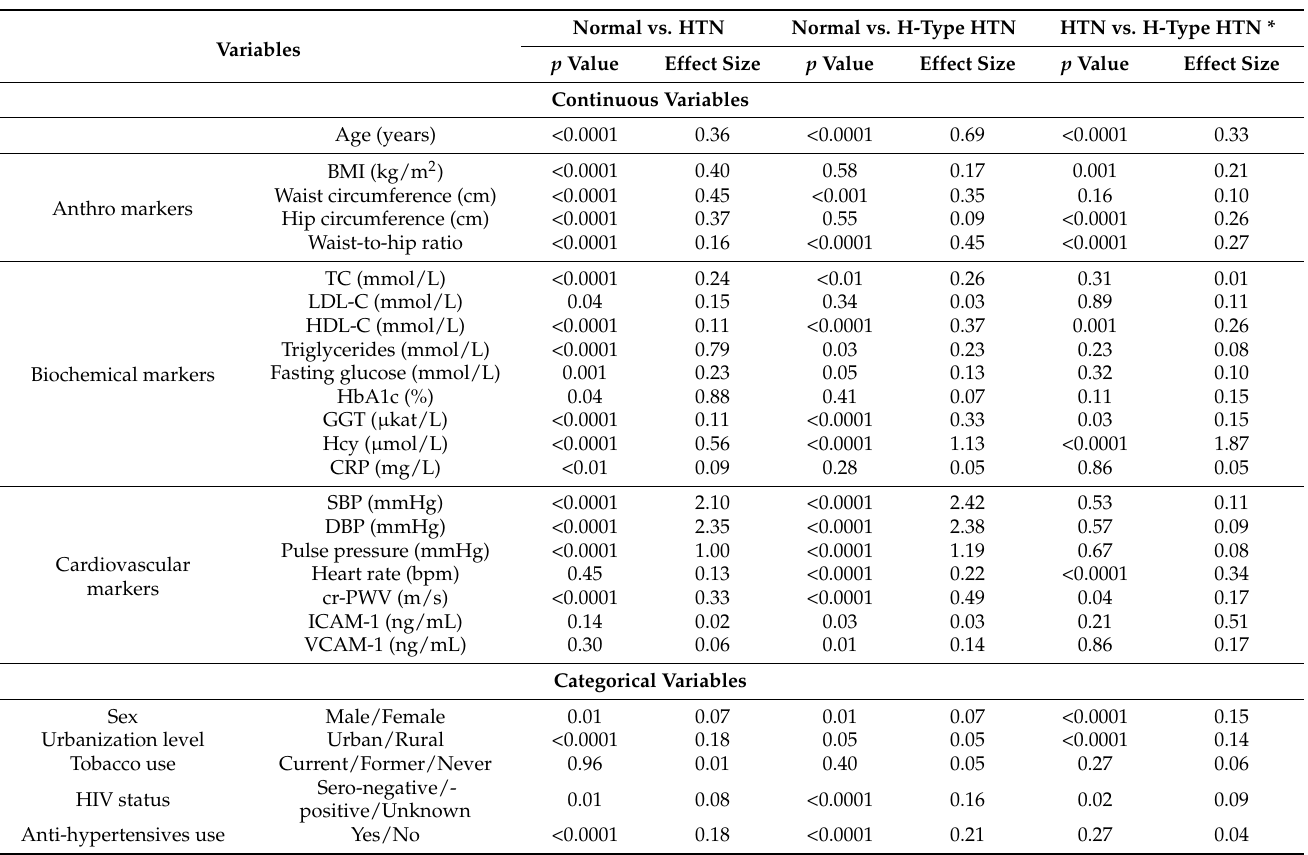
Table 2. Comparison of demographic, anthropometric and biochemical variables between hyperten- sion status sub-groups.